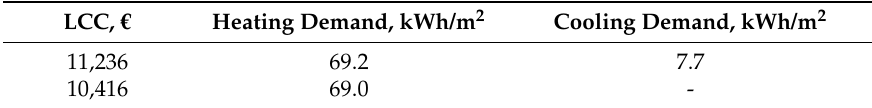
Table 6. Life cycle cost and heating and cooling demand and for reference building. In second line the results for building without cooling (case WC) are